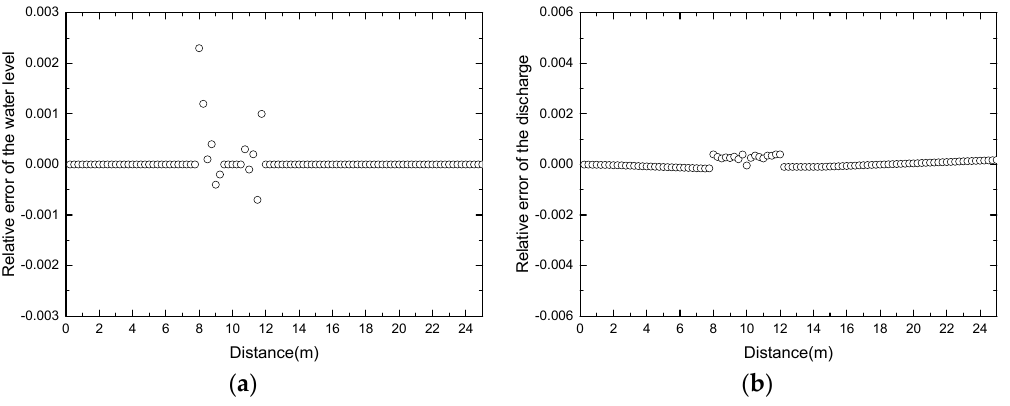
Figure 11. The relative error of subcritical flow over a bump: ( a ) the water level z ; ( b ) the discharge q = hu .